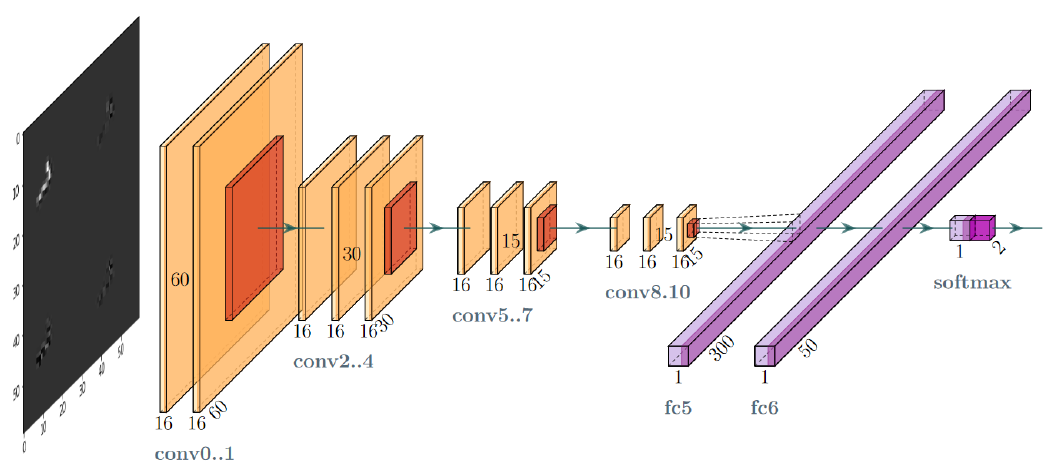
Figure 17. Layer-oriented signal flow in the convolutional network (CNN) artefact filtration model of a smaller